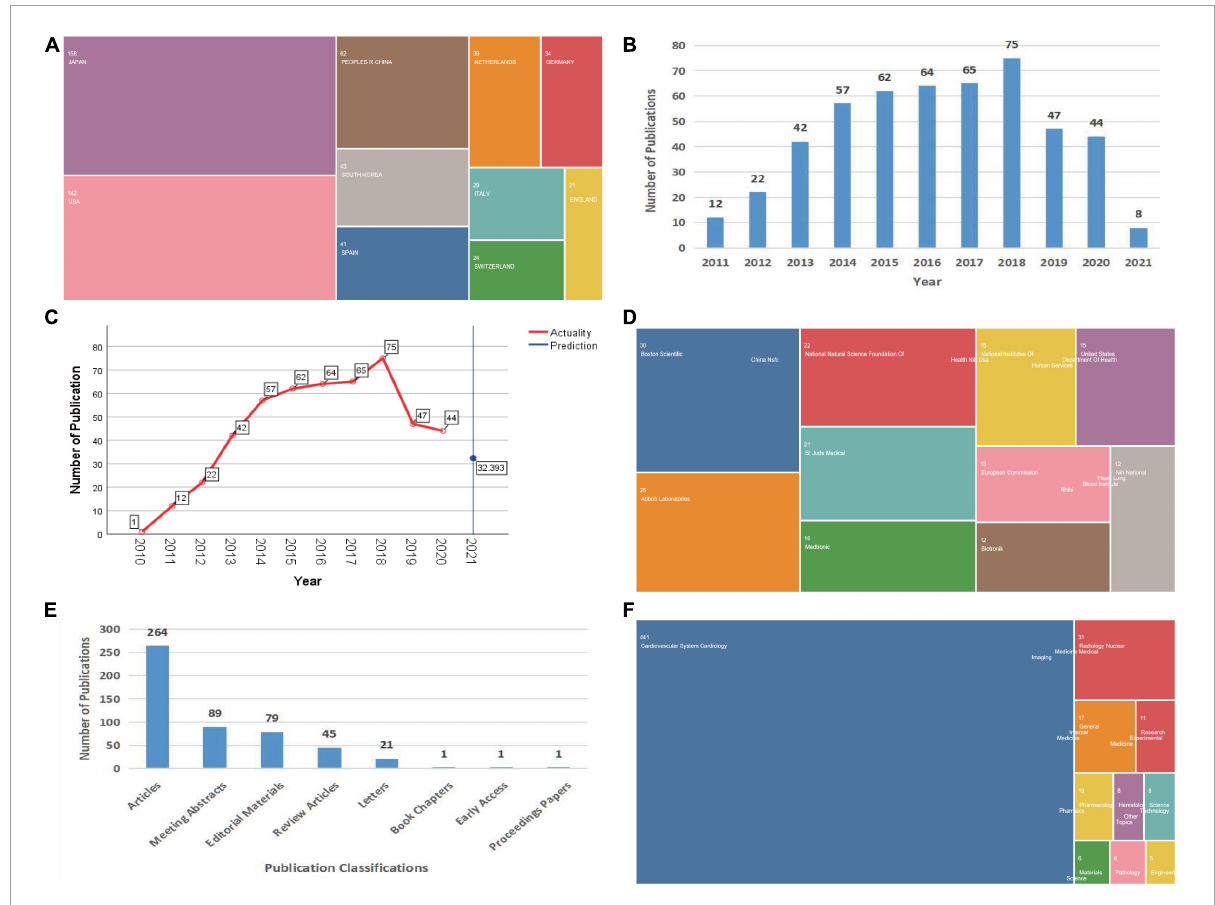
FIGURE1 Global characteristics of articles published in ISNA. (A) Country/region of origin of articles. (B) Annual publication volume of articles. (C) Future publication forecast curve of articles. (D) Source of project fund support. (E) Category classification of articles. (F) WoS catalog classification of research